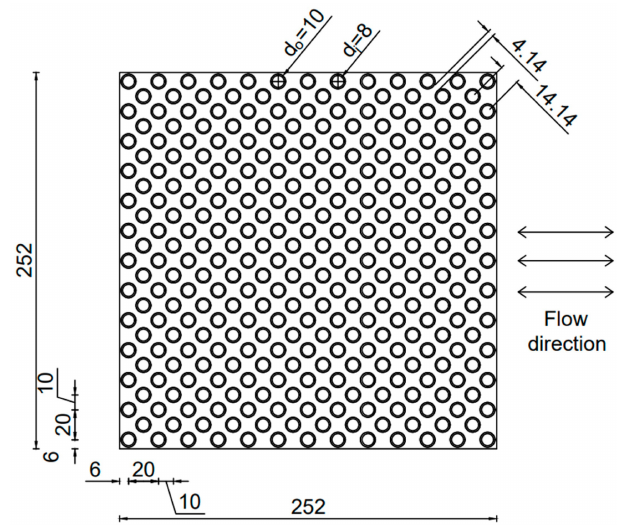
Figure 8. Design of cylinder system with an external diameter of 10 mm in heat exchanger 1.